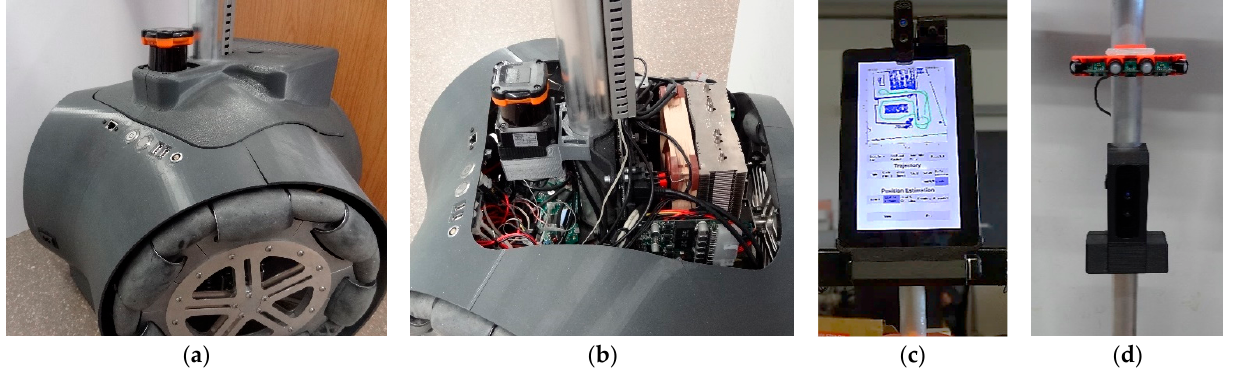
Figure 3. Close view of the APR-02 mobile robot prototype: ( a ) detail of the base of the robot containing the omnidirectional wheels, the characteristic cover, and a 2D Precision LIDAR; ( b ) detail of the interior of the base containing an onboard PC above three lithium batteries; ( c ) detail of the panoramic tactile screen of the robot which has a small black structure on its top to hold and hide an RGB-D and an RGB panoramic camera; and ( d ) detail of the central black structure that holds and hides two RGB-D cameras and of the orange structure that supports PIR sensors and warning lights.